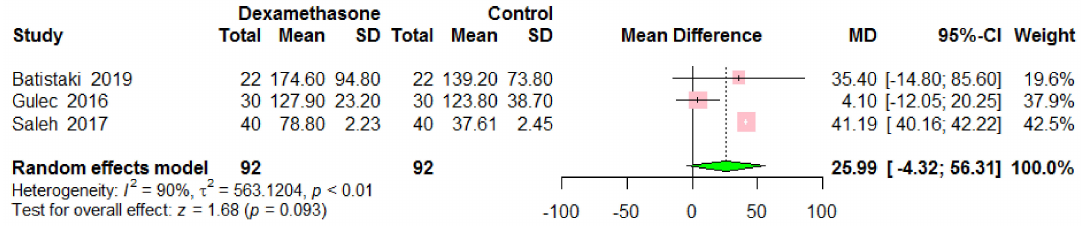
Figure 4. Time to extubation. Dexamethasone administration vs.